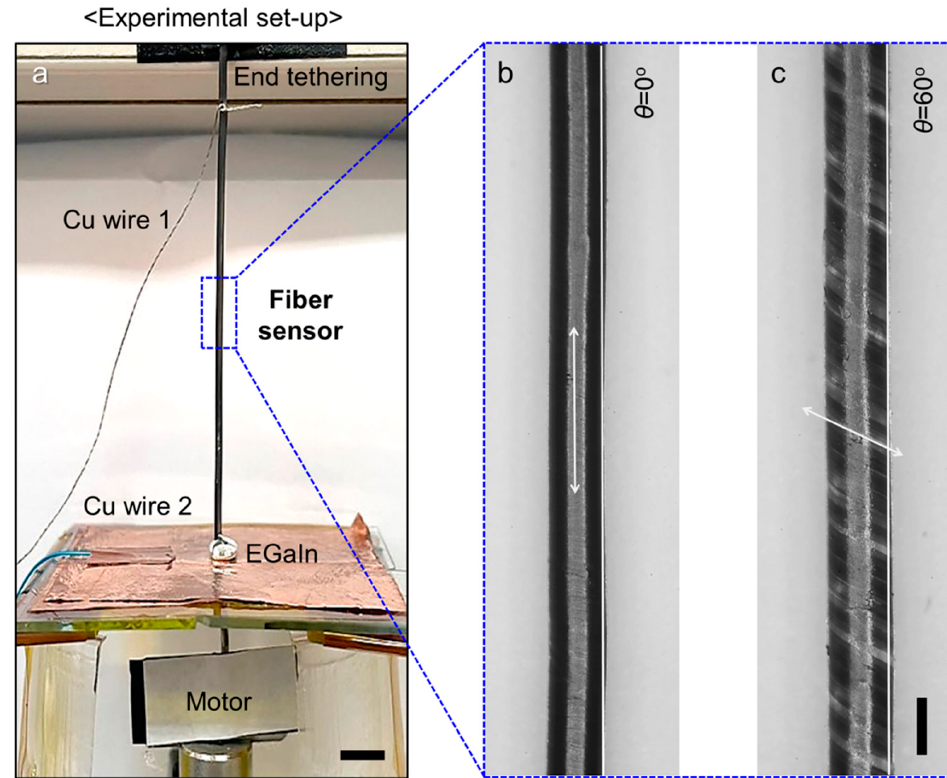
Figure 2. Measurement setup and morphology of the CNT-wrapped core/sheath fiber strain sensor. ( a ) Photograph of the experimental setup for resistance measurement during tensile and torsional deformation (scale bar = 5 mm). Magnified photographs showing CNT-wrapped fiber sensors with ( b ) zero wrapping angle ( 𝜃 = 0 ° ) and ( c ) nonzero wrapping angle ( 𝜃 = 60 ° ) (scale bar = 1 mm).